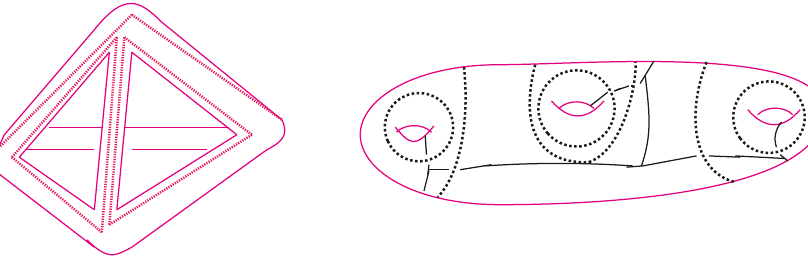
Figure 2 . The left panel shows a Heegaard diagram for the 3-sphere, determined by a triangulation consisting of two tetrahedra. Three attaching curves, corresponding to three of the triangles are depicted as red dashed lines. The attaching curve associated to the fourth (bottom) triangle can be obtained from combining the other three curves. On the right panel the Heegaard surface is deformed into the standard form for a genus 3 surface. Three 2-handle constraints are imposed via vacuum loops. The 2-handle constraint for the fourth triangle (determined by a curve surrounding all three holes) follows from the other three constraints. To see this one has to use the sliding property of the vacuum loops. We have also indicated a basis, which is neither a B 1 basis nor a B 2